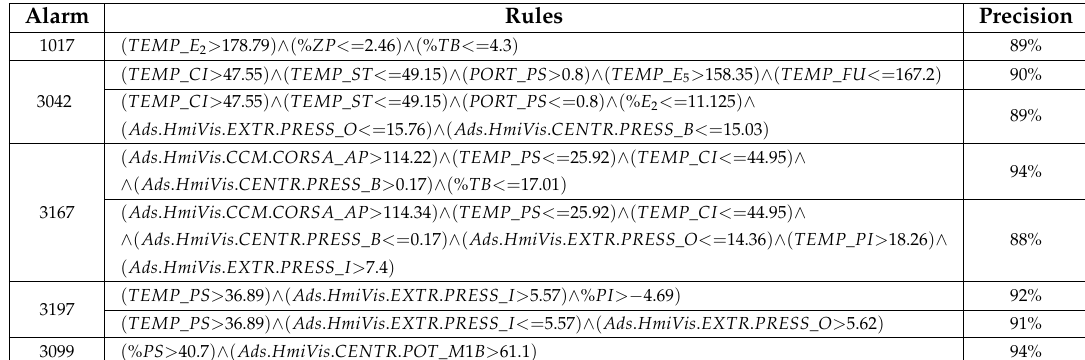
Table 2. Decision Tree (DT) based rule learner (RUL = 0 s).